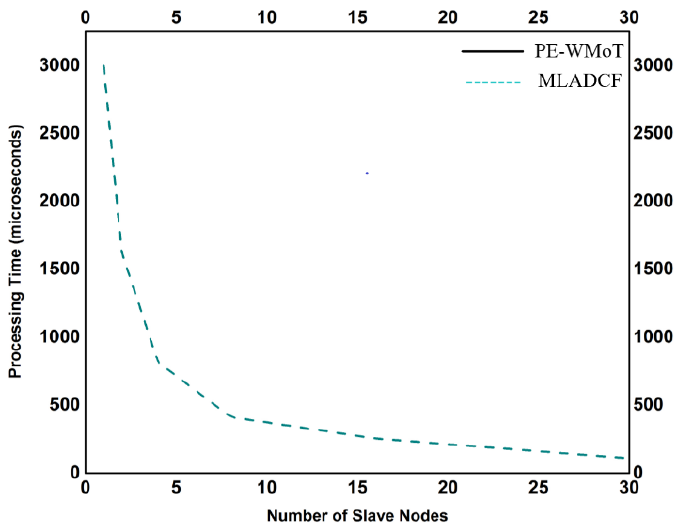
Figure 12. No. of Slave Nodes Vs. Processing Time.